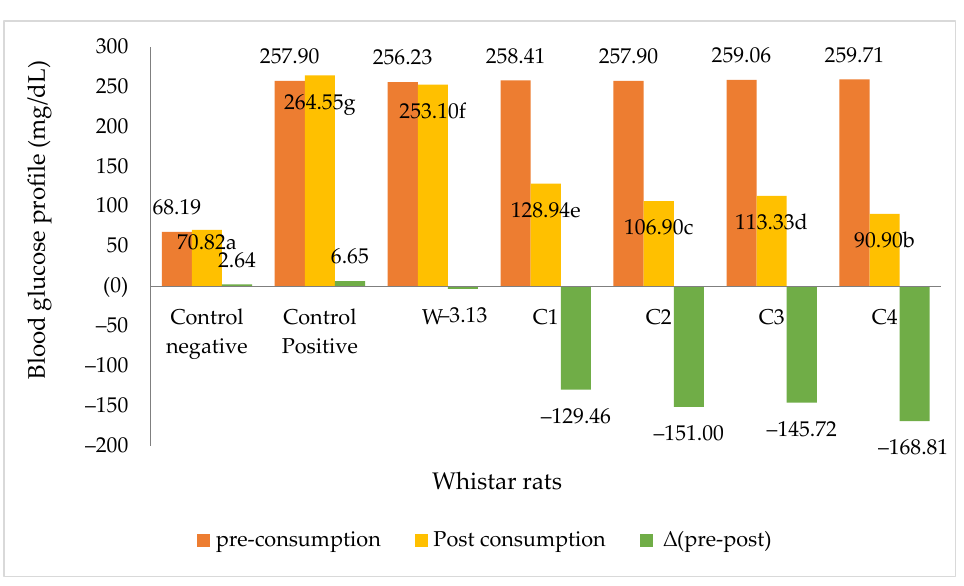
Figure 1. Blood glucose levels in diabetic Wistar rats after four weeks of feeding. Note: Negative control = non-diabetic rats; positive control = diabetic rats with normal diets; W = diabetic rats on wheat cookies diet; C1 = diabetic rats on C1 diet (corn cookies containing granulated sugar and margarine); C2 = diabetic rats on C2 diet (corn cookies containing crystalline coconut sugar and margarine); C3 = diabetic rats on C3 diet (corn cookies containing granulated sugar and VCO); C4 = diabetic rats on C4 diet (corn cookies containing crystalline coconut sugar and VCO). Different letters behind the numbers indicate a significant difference at the 5% level Dietary fibre is made up of the plant polysaccharide lignin, which is resistant to hy- drolysis by human digestive enzymes [9]. Fibre, particularly water-soluble fibre, becomes more viscous in food, slowing the process of absorption of nutrients such as glucose. As a